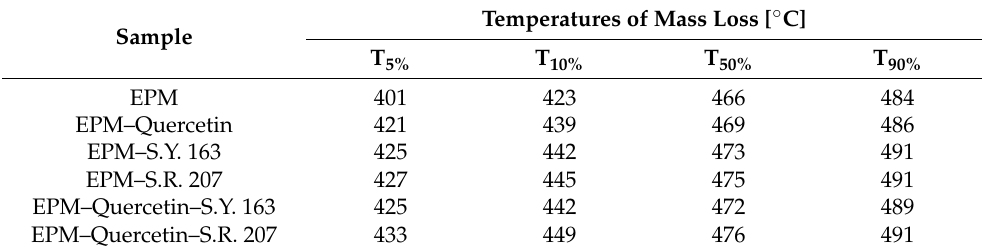
Figure 12. TGA curves obtained for EPM samples with natural and synthetic additives that were heated from 25 to 900 °C. Table 2. Mass loss temperatures, where T x% is the temperature at which a mass loss is equal to x% (5, 10, 50, and